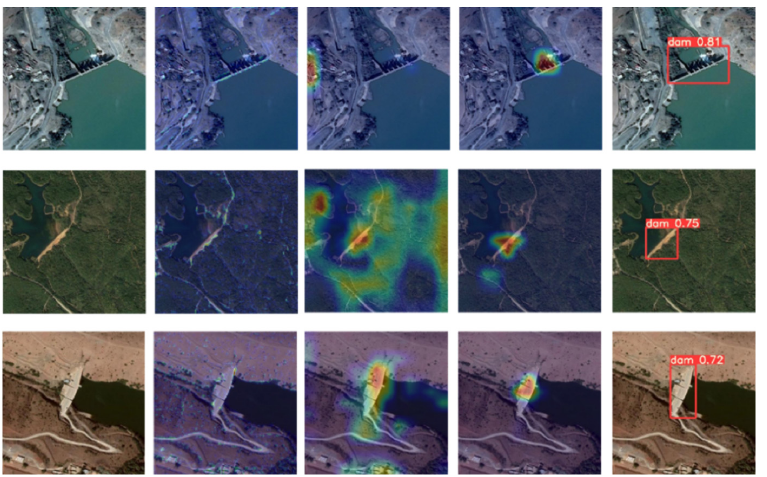
Figure 17. Grad-CAM maps of several critical layers in the dam detection process. The first column shows the original images. The middle three columns are the Grad-CAM maps, Backbone+ViT, and the BiFPN convolution layers. The last column is the visualization of the bounding boxes.